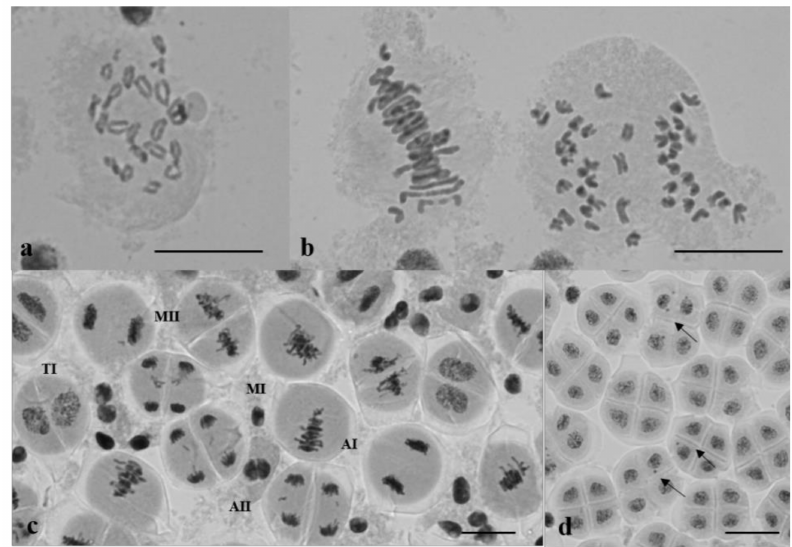
Figure 13. The behavior of chromosomes undergoing meiosis in plants of Group 1: ( a ) Diakinesis— chromosomes form bivalents; ( b ) metaphase I and anaphase I. Two univalents in a meiocyte at metaphase I; univalents arrested on the metaphase plate at anaphase I; ( c ) cell cycle asynchronization in meiocytes in one anther; meiocytes at MI–AII; ( d ) meiocytes at TII; micronuclei are shown with arrows. Staining acetocarmine. Scale bar 10 µ